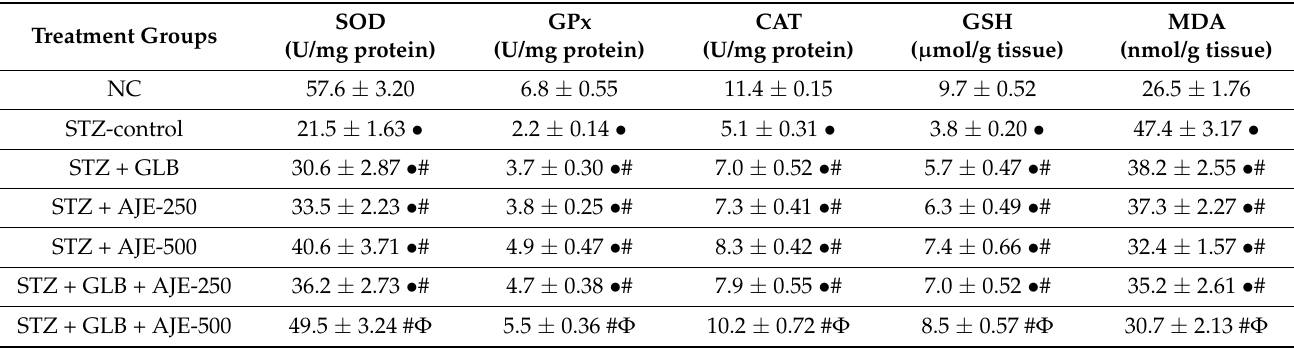
Table 7. Effect of GLB, AJE, and their combination on oxidative stress and LPO parameters in pancreatic tissues of STZ-diabetic